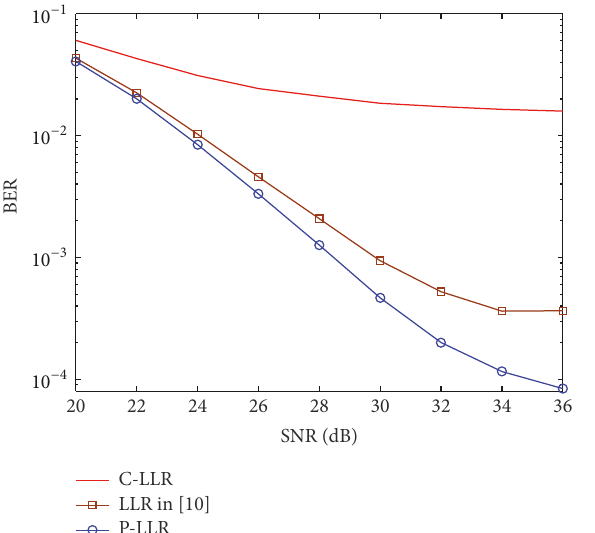
Figure 3: BER performance of various LLR algorithms for 1024-